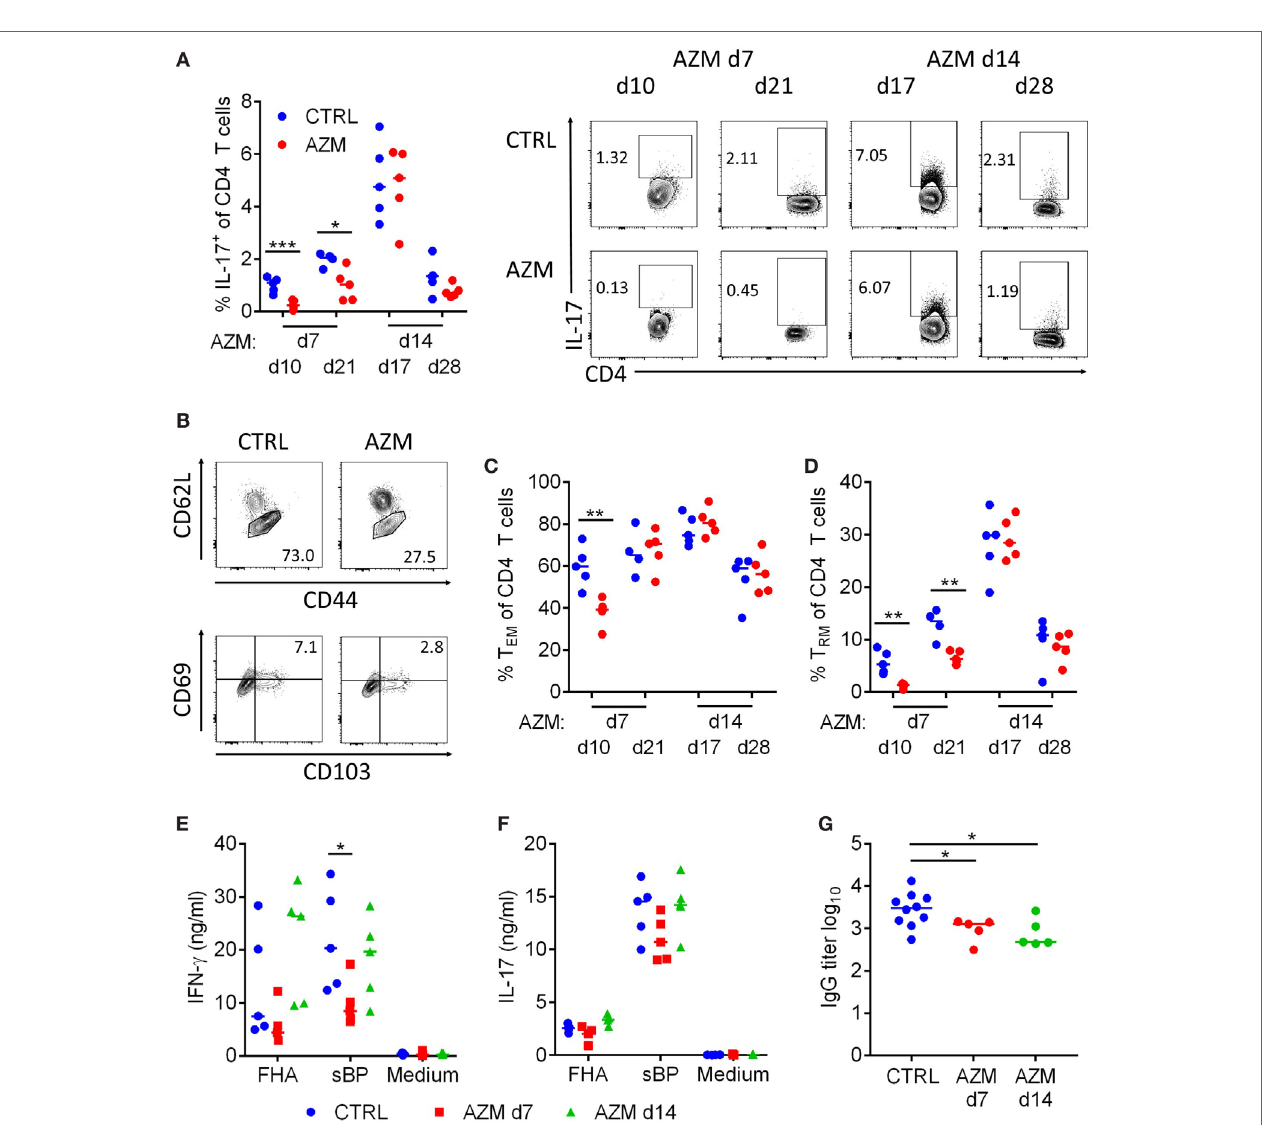
FigUre 3 | Azithromycin (AZM) treatment at 7 days post Bordetella pertussis challenge modulates induction of T cell and antibody responses. CD4 T cells in lung digests were characterized by flow cytometry. The percentage of IL-17-producing cells in the CD4 population was analyzed via intracellular cytokine staining 3 and 14 days after treatment. Representative dot plots of the CD4 + population are shown (a) . T EM (CD62L low CD44 + ) (c) and tissue-resident memory T (T RM ) (CD62L low CD44 + CD69 + CD103 + ) (D) were analyzed 3 and 14 days after treatment. (B) Upper panels show representative dot plots of the CD4 + population on day 10, lower panels show representative dot plots of the T EM population on day 10. Splenocytes were obtained 28 days post challenge (dpc) and stimulated with filamentous hemagglutinin (FHA) or sBP for 72 h. IFN- γ (e) and IL-17 (F) production in the supernatants were determined via ELISA. Serum was collected from mice on 28 dpc and FHA-specific total IgG serum titers were determined via ELISA (g) . (a,c–g) Horizontal lines indicate mean. Significances were determined via t -test, * p < 0.05, ** p < 0.01, *** p <